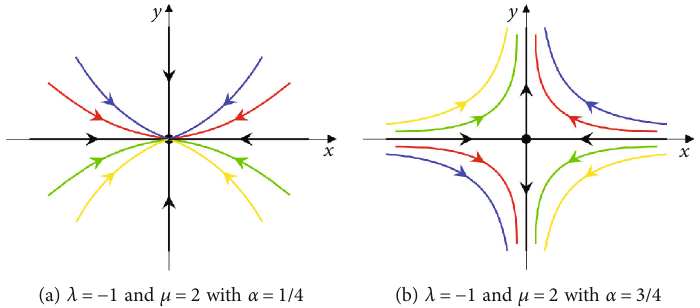
Figure 5: The phase portraits of system (8) for λ < 0 < μ at di ff erent α .